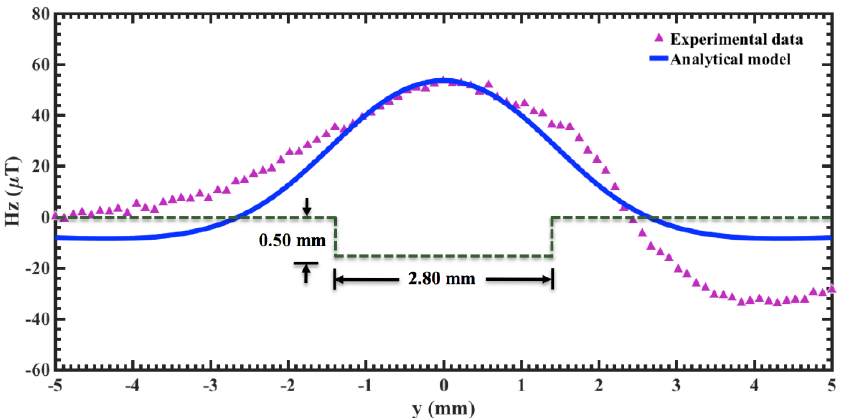
Appl. Sci. 2018 , 8 , x FOR PEER REVIEW Figure 9. Tangential MMM signal of the rectangular defect S3 of the ASTM A-36 steel pipe.